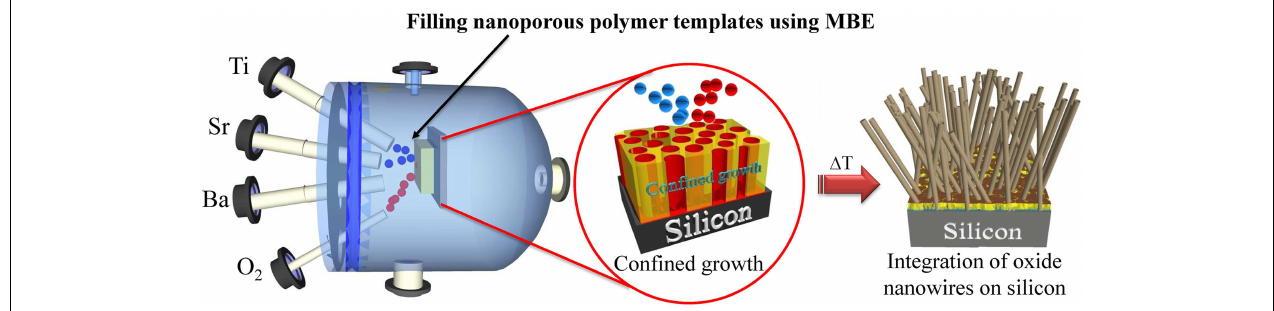
FIGURE 7 | Scheme of an O-MBE setup that shows the epitaxial integration of oxides nanowires on silicon through a metallic evaporation under atomic oxygen inside the pores of a supported track etched polymer templates.